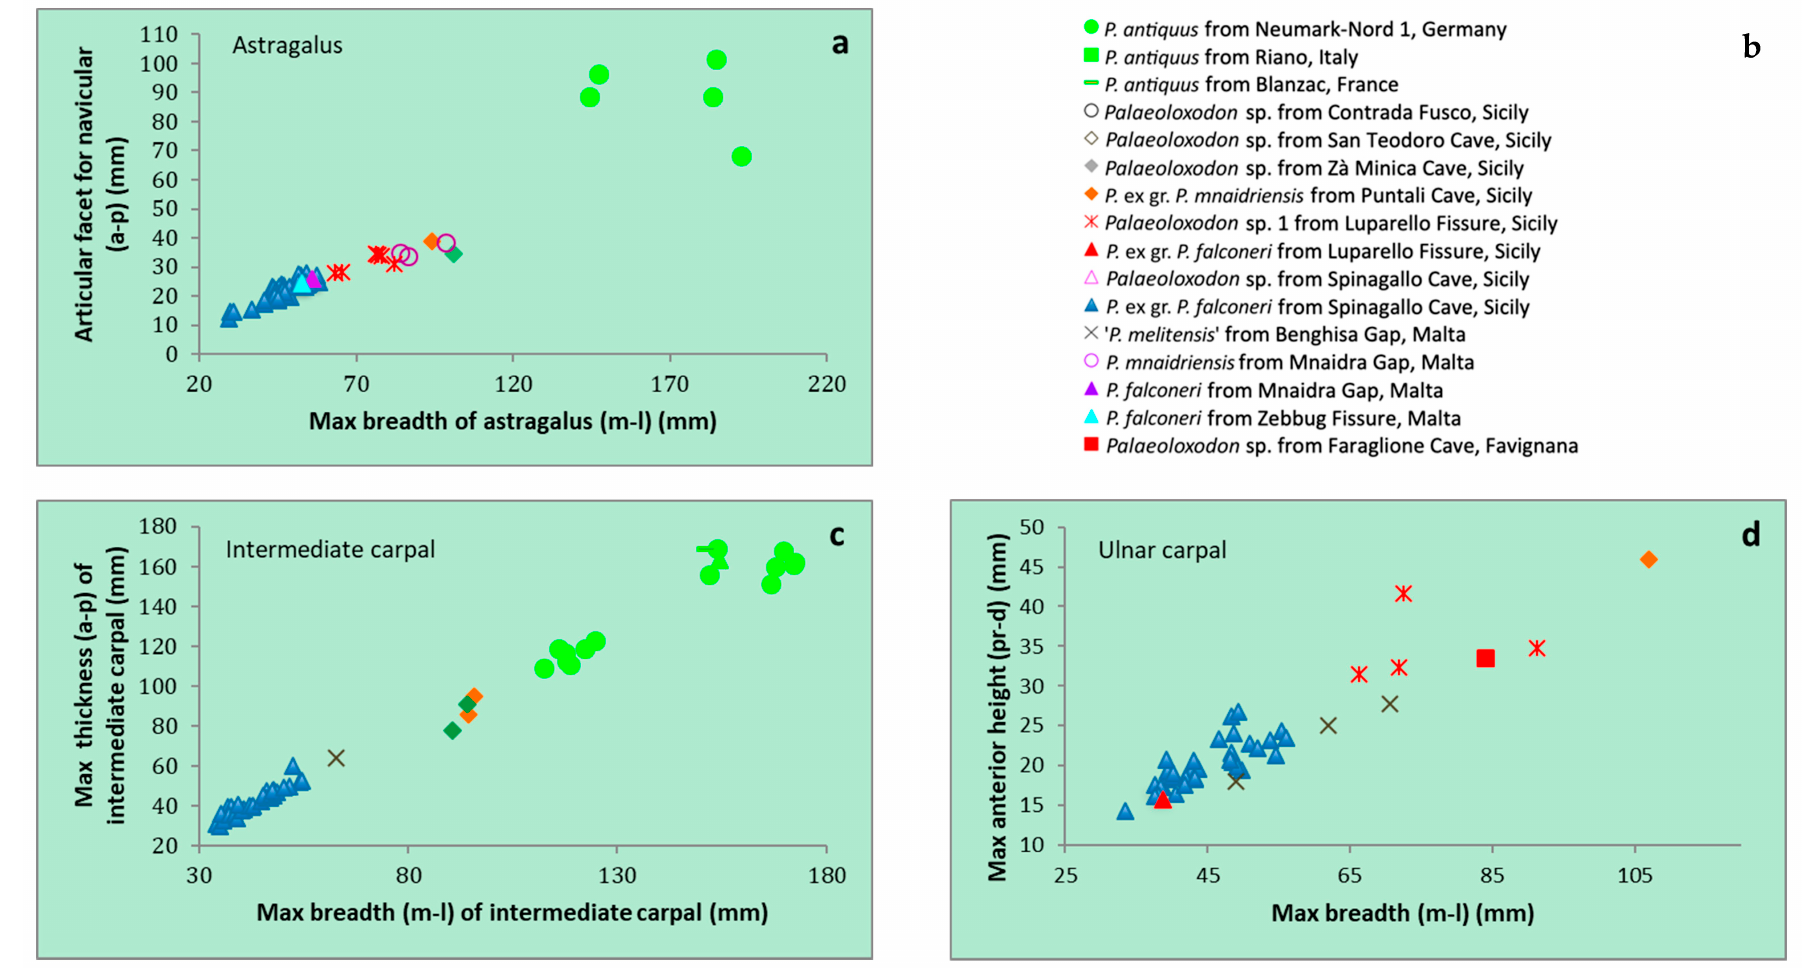
Figure 3. Scatterplot of the dimensions of the foot bones ( a ) Max breadth of astragalus (m-l) vs. articular facet for navicular (a-p). ( b ) Figure legend. ( c ) Intermediate carpal max breadth (m-l) vs. max thickness (a-p). ( d ) Ulnar carpal max breadth vs. max anterior height. Data sources: P. antiquus from Palombo et al., unpublished. All remaining data are